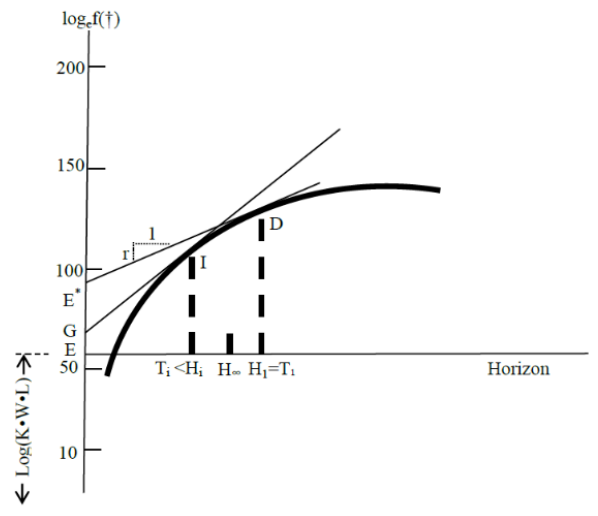
Figure 2. Transitory shock lengthens period of investment.